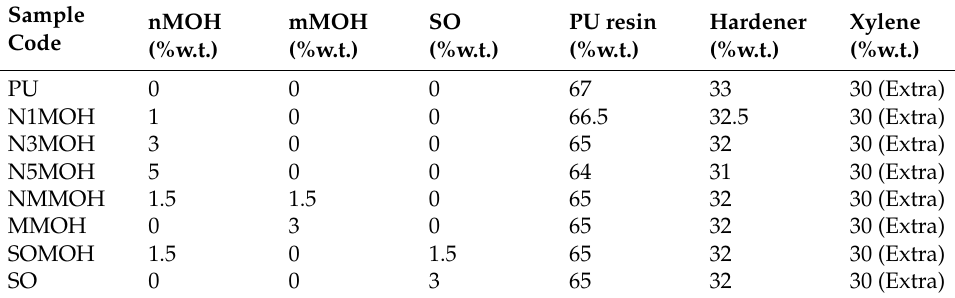
Table 2. The chemical information of the PU composite